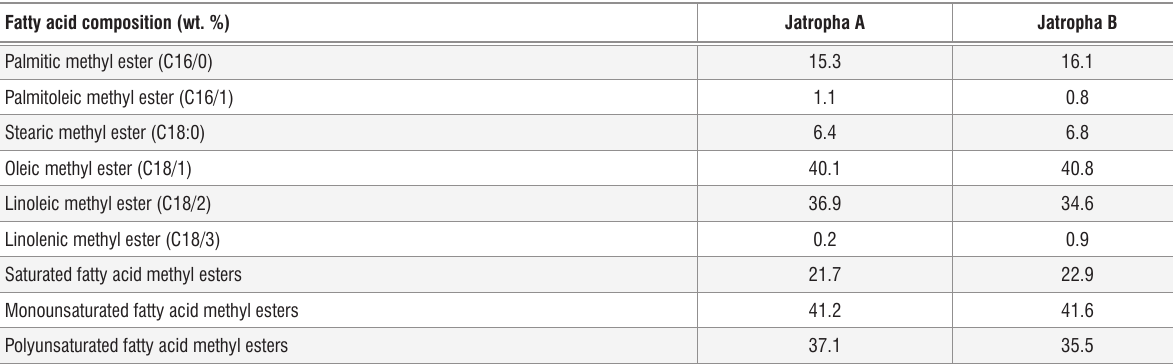
Fatty acid composition of Jatropha curcas samples Fatty acid composition (wt. %)